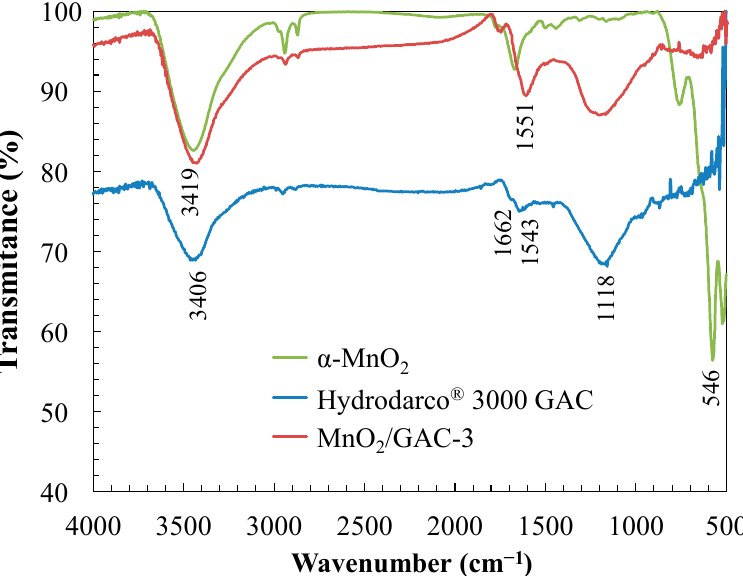
Figure 9. FTIR spectrum of the region between 4000 and 500 cm − 1 of α -MnO 2 nanoparticles, GAC Hydrodarco ® 3000, and MnO 2 /GAC-3 composite.